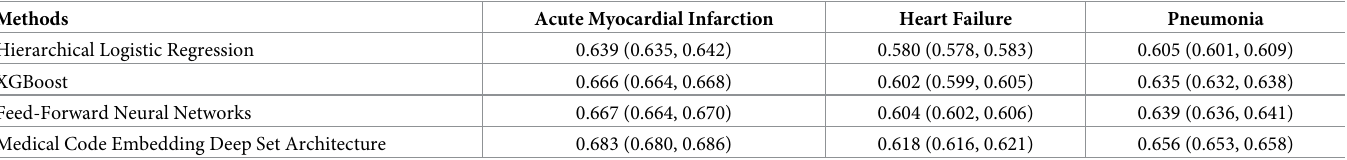
Table 2. Summary statistics of ICD-9CM diagnosis and procedure codes for each